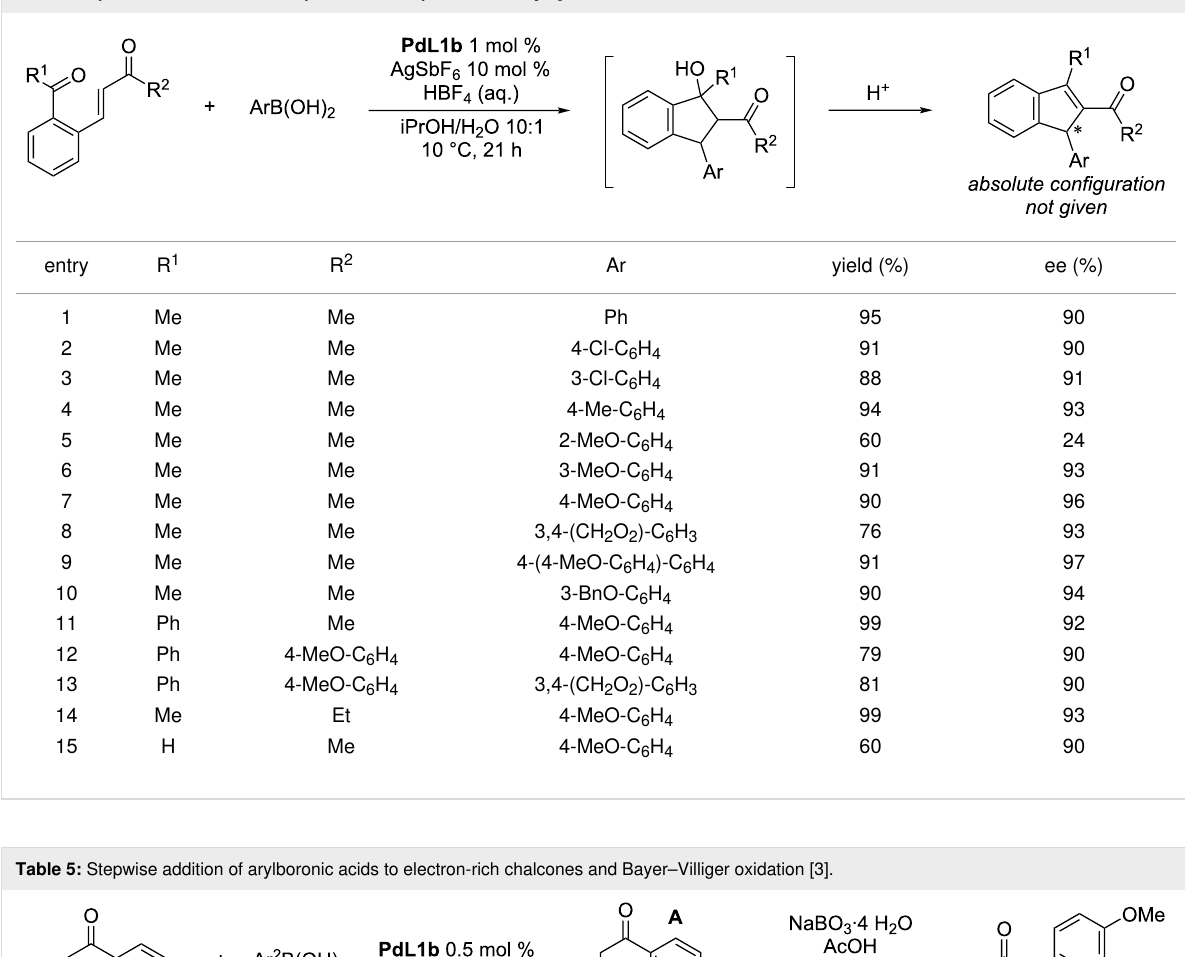
Table 4: Synthesis of enantiomerically enriched 1-aryl-1 H -indenes [36].